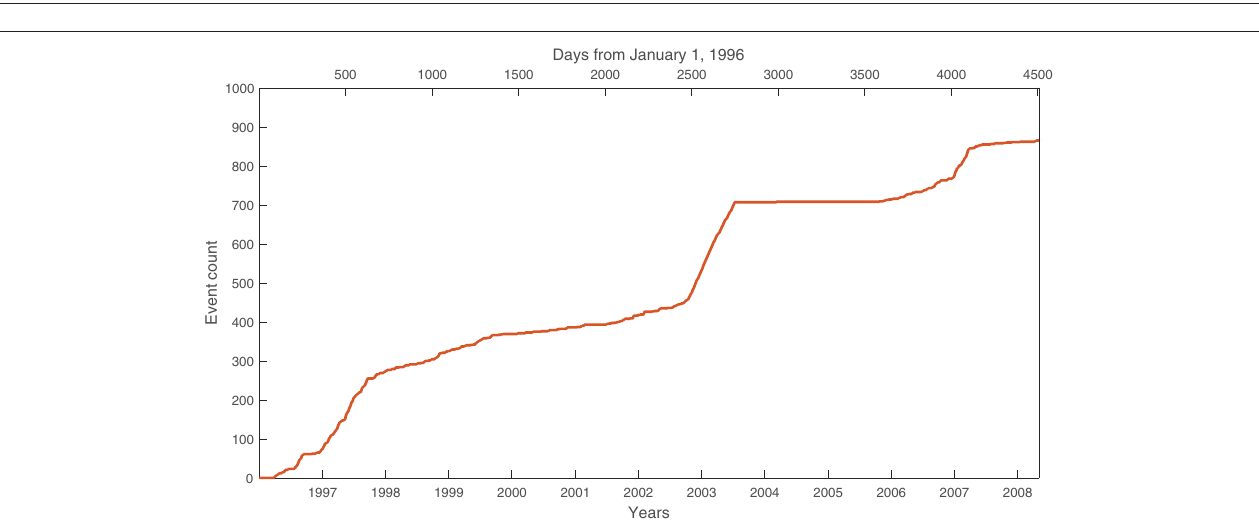
FIGURE 2 | Volumes angular extent of direction of collapse of PDCs in this epoch; radii indicate volumes on logarithmic scale; thick red arcs show valley(s) of major flows at times (labeled above each subplot) ending each epoch.